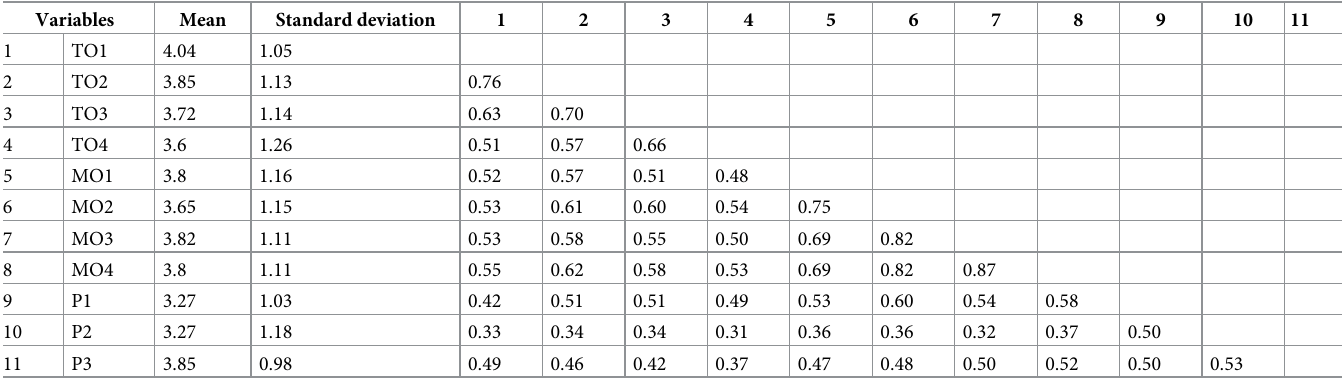
Table 2. Basic descriptive statistics of the constructs.